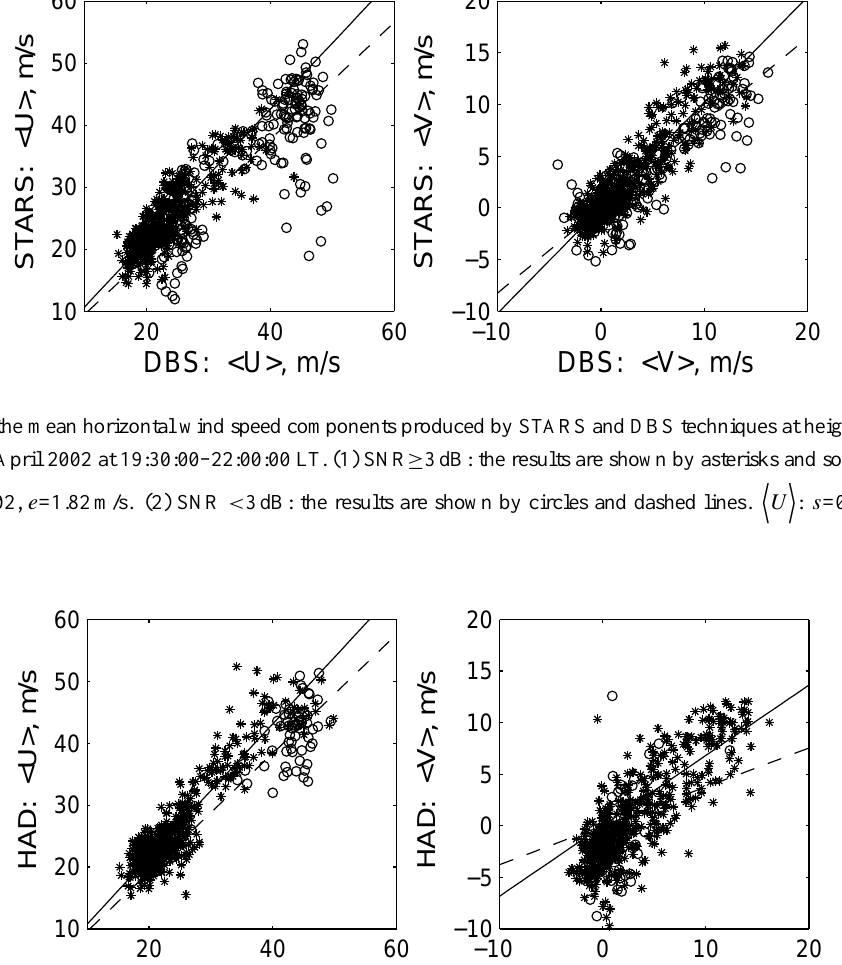
D E V : s =0.68, e =2.66m/s. (2) SNR